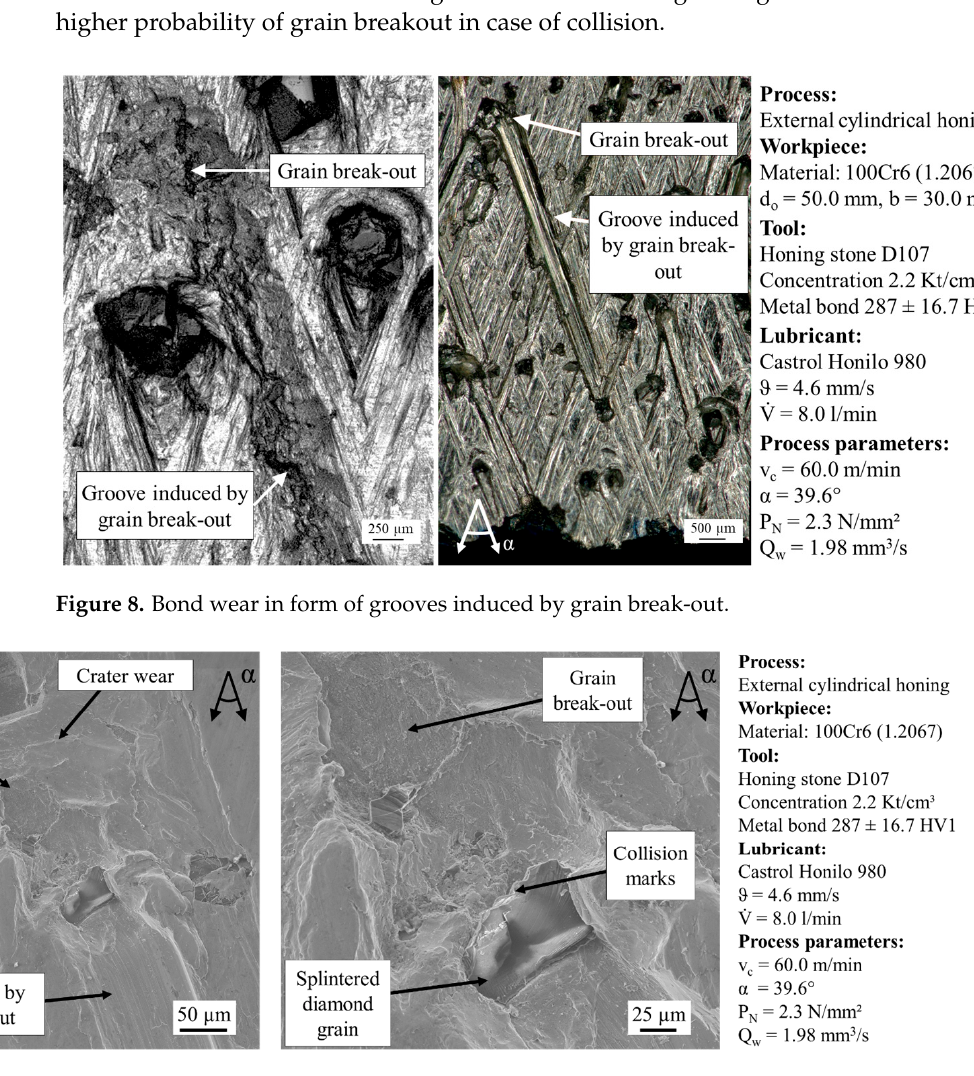
Figure 9. SEM images of grain collisions.